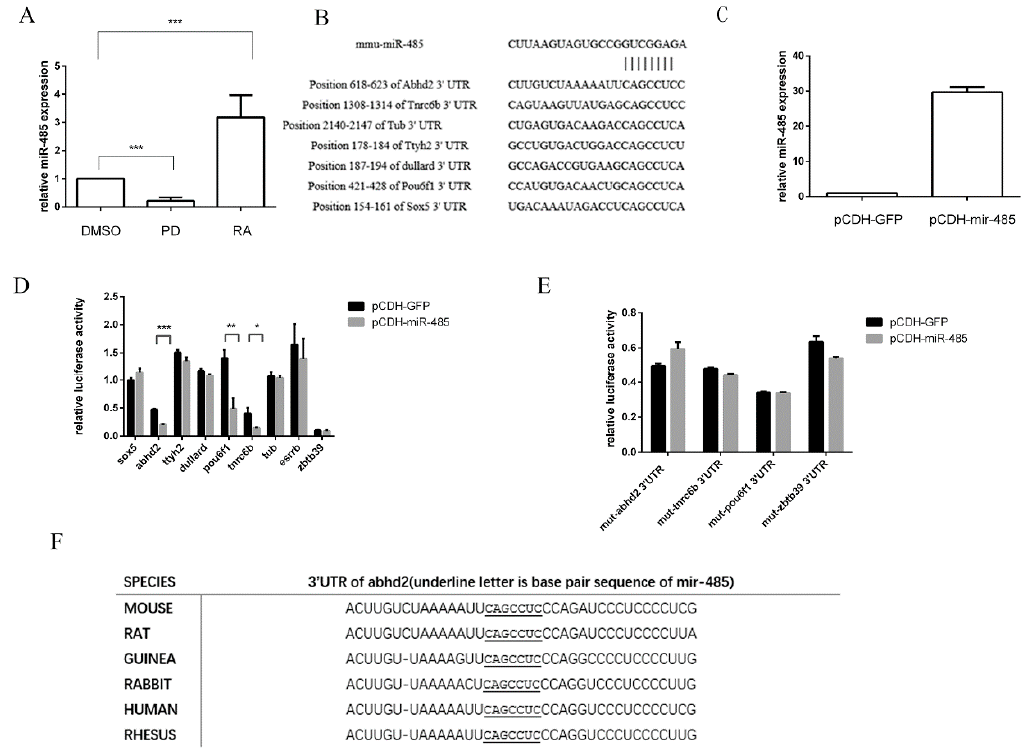
Figure 1. miR-485 is involved in RA-induced differentiation through the MAPK/Erk pathway and Abhd2 is a target of miR-485. ( A ) qPCR analysis of mir-485. Normally cultured F9 ECs were treated with RA (2 μ M) or an equal volume of PD or DMSO for 36 h. Data are presented as mean ± SD of three independent experiments. ( B ) 3 ′ -UTR analysis of nine target genes containing putative regions that match the seed sequence of miR-485. ( C ) qPCR analysis of miR-485 expression in F9 EC cells transfected with vector pCDH-GFP or pCDH-miR-485 for 36 h. ( D ) Dual-luciferase reporter assay of 3 ′ -UTR of nine genes. psiCHECK2 Plasmids containing 3 ′ -UTR of nine genes was transfected into F9 ECs, after 36 h, the luciferase activity was determined. ( E ) Dual-luciferase reporter assay of mutant 3 ′ -UTR of nine genes. Data are presented as the mean ± SD of three independent experiments (* p < 0.05; ** p < 0.01; *** p < 0.001). ( F ) Sequence alignment of mouse ( Mus) miR-485 with the 3 ′ -UTRs of Abhd2 of mouse, rat, guinea, rabbit, human, rhesus.